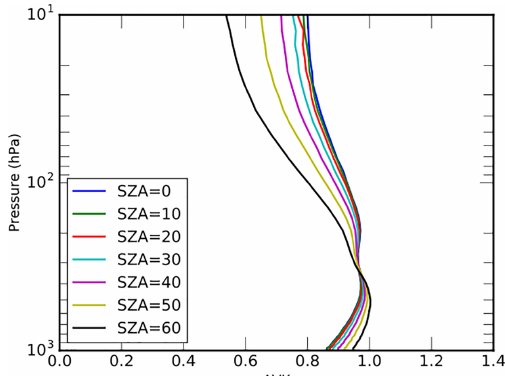
Figure 5. Averaging kernel ( ˆ AK) values for CO 2 for different val- ues of solar zenith angles. Calculations for CO 2 have been done assuming a mini-LHR SNR of 500 (although in reality SNR varies with solar zenith angle (SZA) and is highest near an SZA of 0) and assuming a background variability of